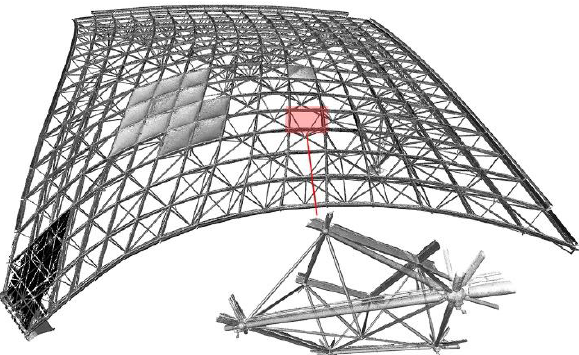
Figure 7: Range-based point cloud.